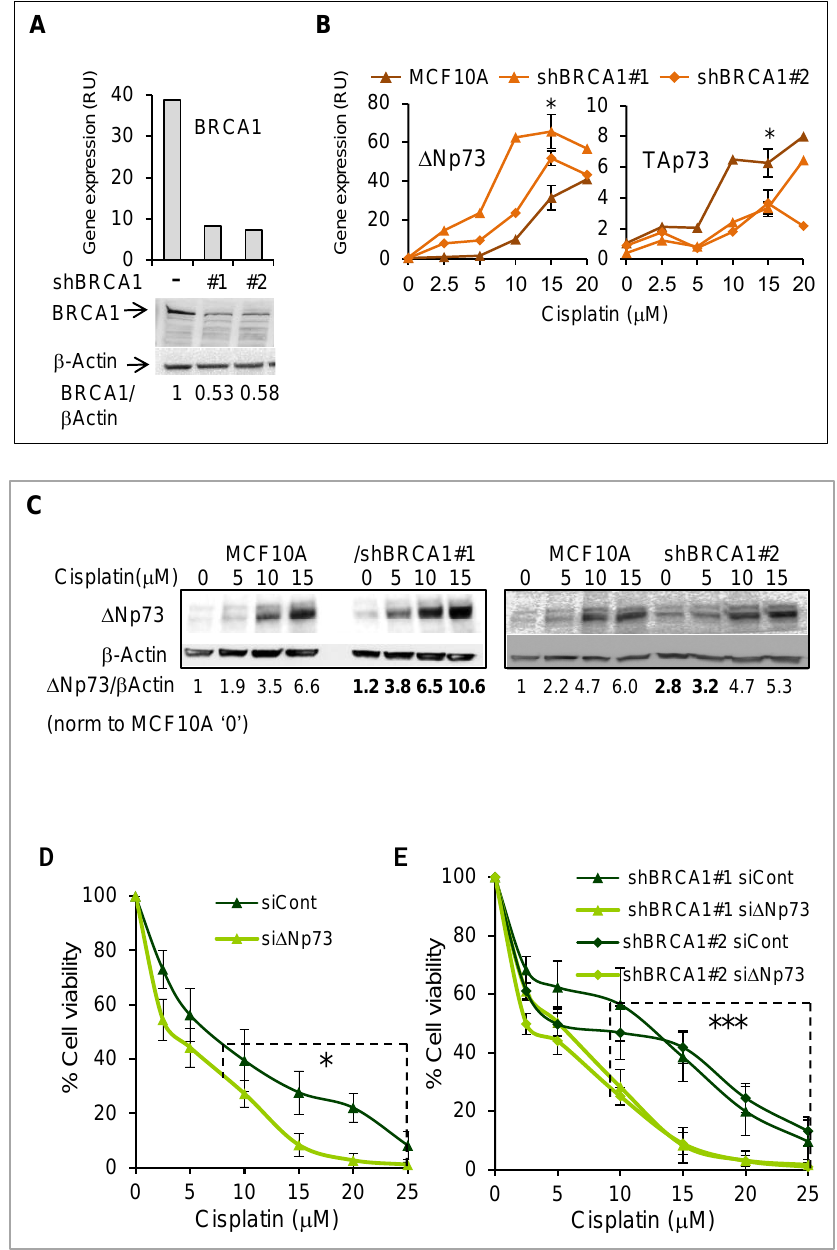
Figure 4. Induction of deltaNp73 and its protective effect on cell viability were augmented in BRCA1 knocked-down MCF10A following treatment with cisplatin. Stable knockdown of BRCA1 (BRCA1- KD ) in MCF10A was performed by two different shRNAs (shBRCA1#1 & #2). ( A ) BRCA1 mRNA (upper panel) and protein (lower panel) are shown for BRCA1-wt cells and the BRCA- KD clones. ( B ) Induction of deltaNp73 mRNA by cisplatin was greater in the BRCA1- KD than in the parental MCF10A cells (left), while the induction of TAp73 was reciprocally suppressed in the BRCA1- KD cells (right). The data point of 15 μM cisplatin represents average of three independent experiments with error bars of S.E.M. The differences in gene expression between the parental MCF10A cells and